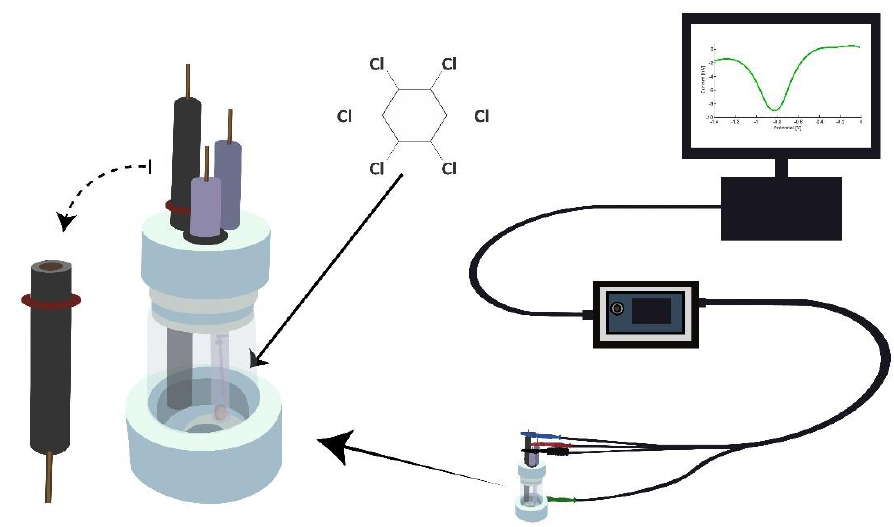
Figure 1. Electrochemical setup used in the study consisting of electrochemical cell, a potentiostat connected to a computer system to run the measurement and record data.